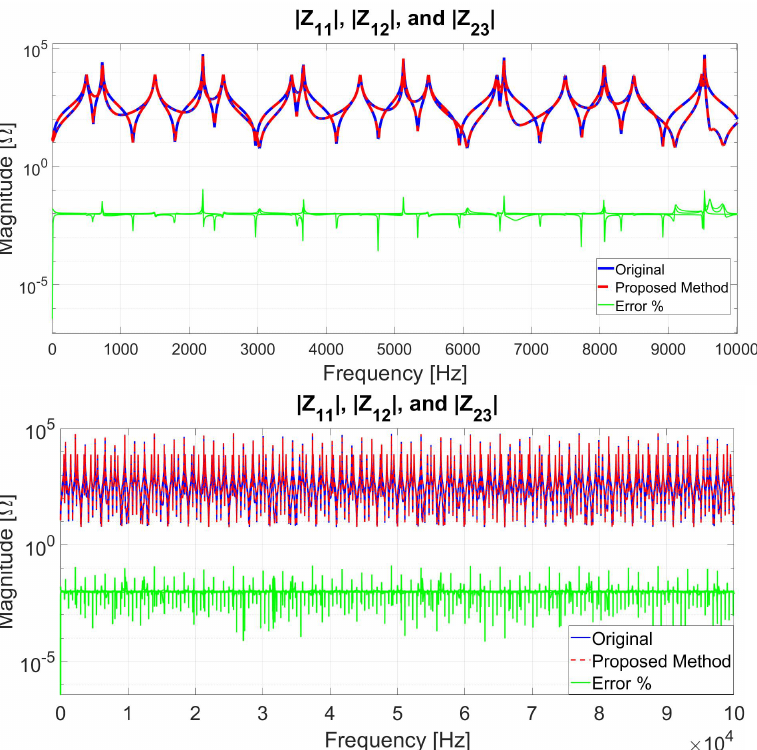
Figure 21. The magnitude of the measured and fitted impedance using the proposed model, | Z 11 | , | Z | , and | Z | . 23 12